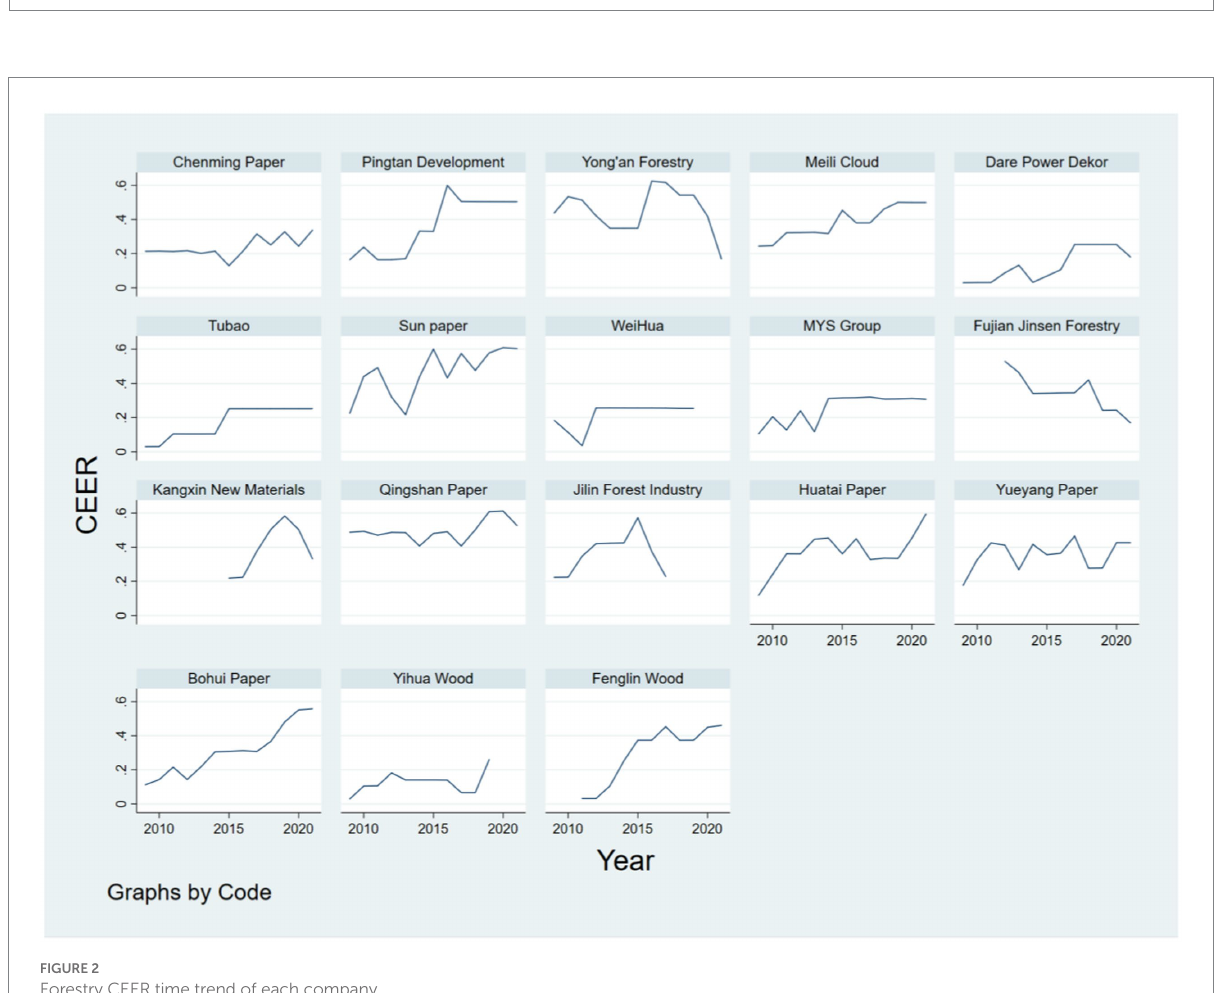
constantly improving and also indicates a constantly increasing attention in the country and society toward the ecological environment. Figure 2 shows the time trend of each company. Most enterprises show an apparent upward trend, while Fujian Jinsen